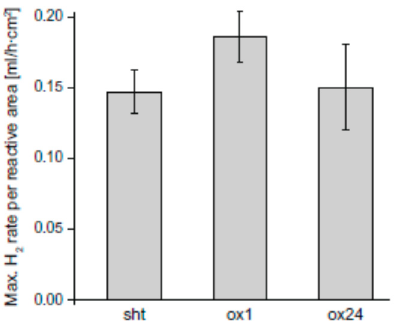
Figure 34. Maximum hydrogen evolution rate for different WE43 samples. Reproduced with permission from [164], Elsevier, 2009.